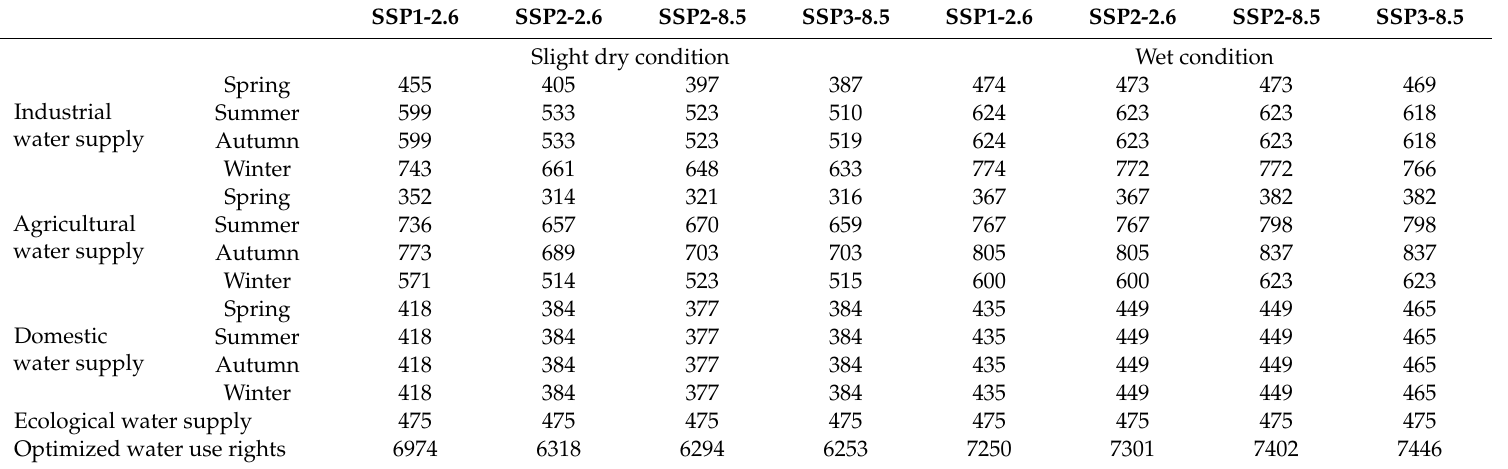
Table 5. Water supply with varying available water in Shaanxi province (ten thousand m 3 ).